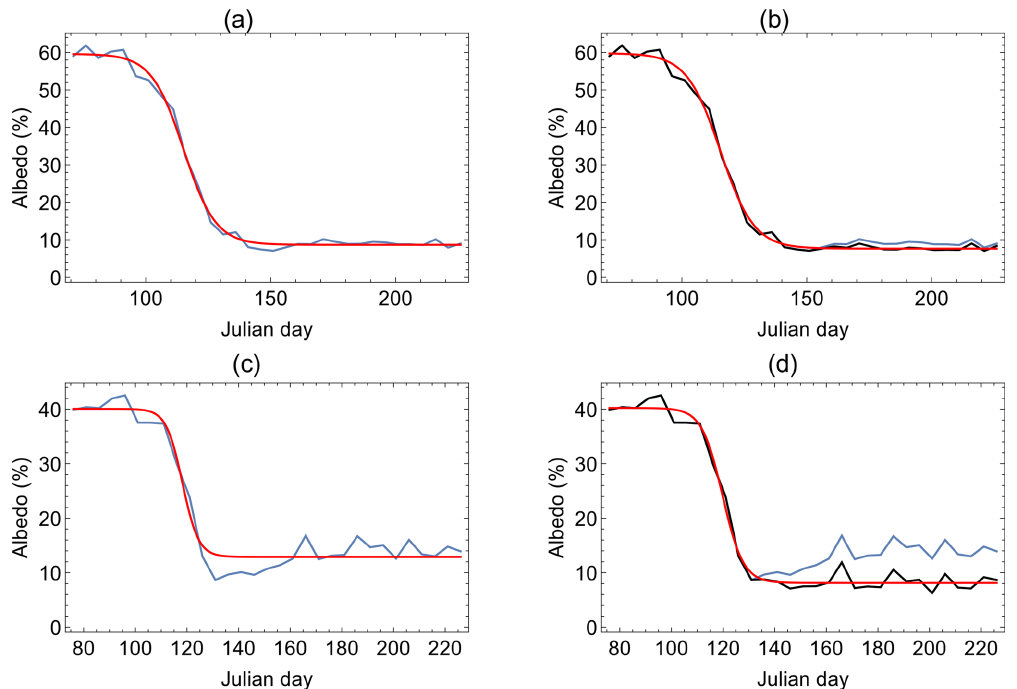
Figure 2. Examples of sigmoid fitting. The original data points are shown in blue; the fit in red; and the data points, from which the vegetation greening effect has been removed, in black. (a) Initial fit of the easy case, (b) final fit of the easy case, (c) initial fit of a case with strong influence of vegetation greening on albedo and (d) final fit of the case with strong influence of vegetation greening on